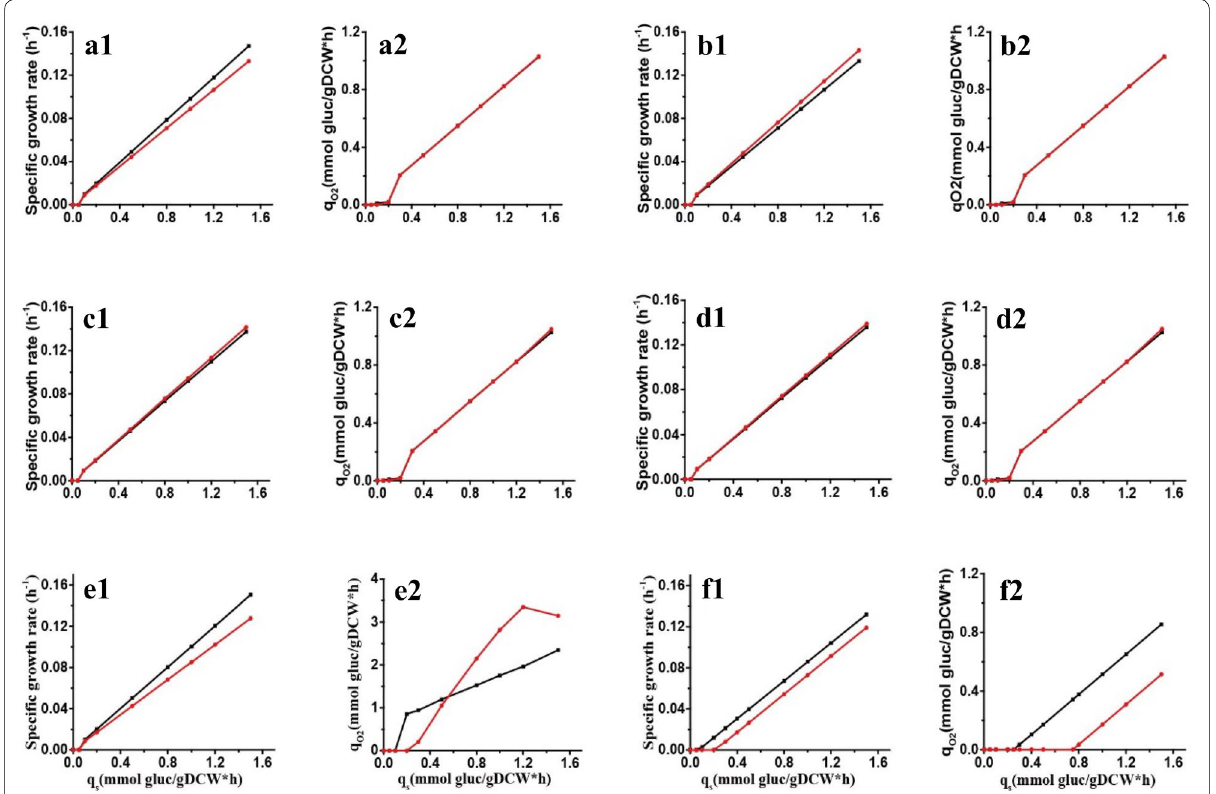
Fig. 3 Sensitivity analysis of different model parameters by the model iZZ1342. The effects of each parameter when changing the specific growth rate (A1–F1) and the specific oxygen uptake rate (A2–F2) with iZZ1342. The simulations were performed in the glucose-limited condition by varying the protein content (22.8–68.4%). a The RNA content (4.9–14.7%), b the DNA content (2.2–6.6%), c the cofactor content (1.5–4.5%), d the GAM content (16–48 mmol ATP/gDCW h), e the NGAM content (1.25–3.75 mmol ATP/gDCW h), f red represents the simulated results of the high value of the input parameter and black represents the lower